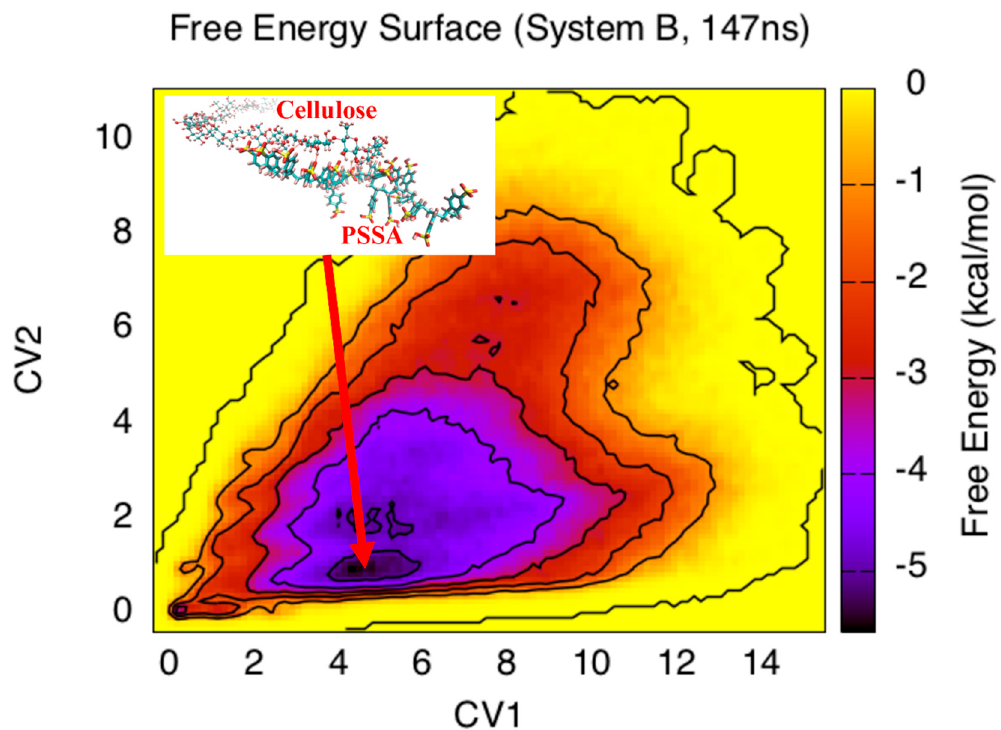
Figure 6. The 2D free energy surface contour plot for system B involving DP 20 ionized PSSA and DP 20 cellulose chain interactions in water. CV1 and CV2 represent the numbers of hydrogen bonds formed between the two polymer chains.